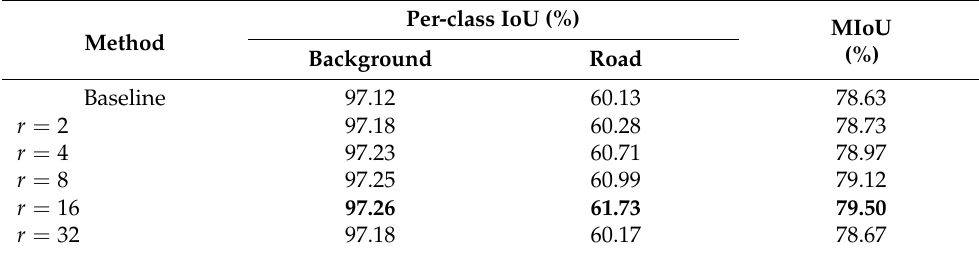
Table 3. Comparison of dimensionality reduction rates of strip attention modules based on the CHN6-CUG dataset. (Data in bold are the best results.).